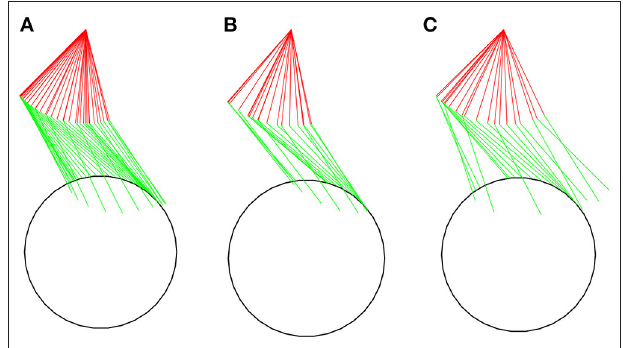
FIGURE 3 | Stick figures representing snapshots of the predicted kinematics for unassisted locomotion on a level surface at an average speed of 0.9 m/s for a complete cycle in the steady state simulation (A) , for the first (B) , and second (C) complete cycles for the startup simulation.